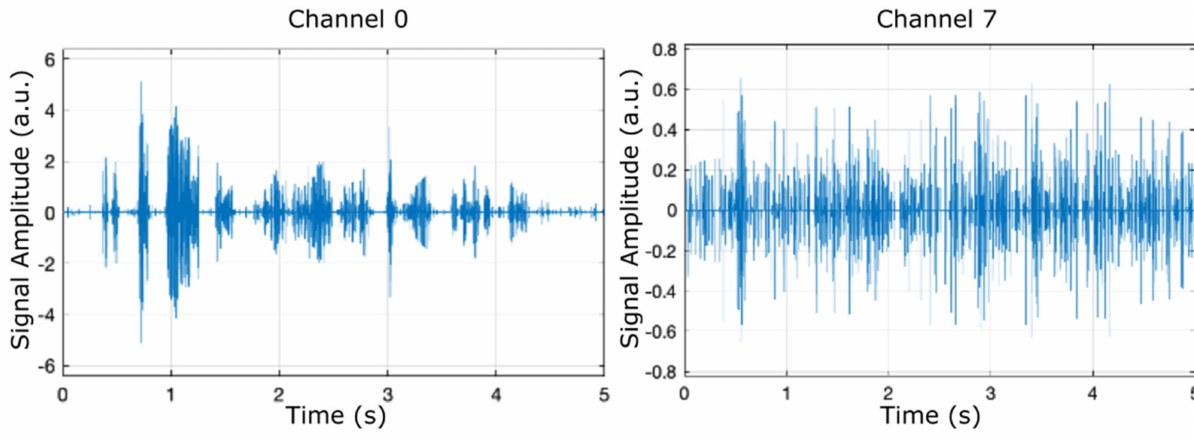
Figure 7. Results of electrical pulse generator for two of the 8 channels (channel 0 and channel 7) under the FIR filter, with Gaussian noise, and the denoise block active (scenario as in Table